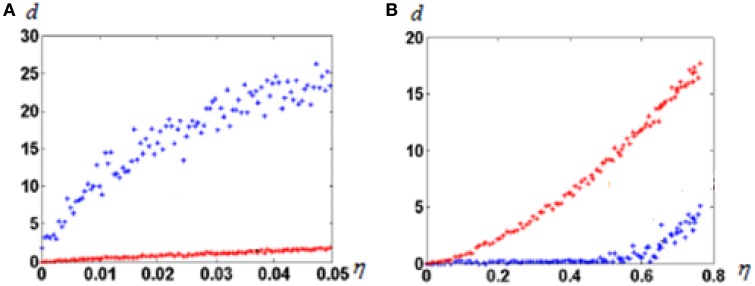
Noise dependence of “output error” of neural network responses. (A) Before learning; (B) After learning. Blue dots, attractor neural network; red dots, not connected neurons. Note the huge difference of abscissa scales between (A) and (B). R = 100; N = 300; M = 100; L = 20. Note that before learning the attractor neural network enhances the input error. That happens because noise might force neural network to get to other attractors than imposed by a noiseless signal. The Figure demonstrates that the learned attractor network has strong noise tolerance.